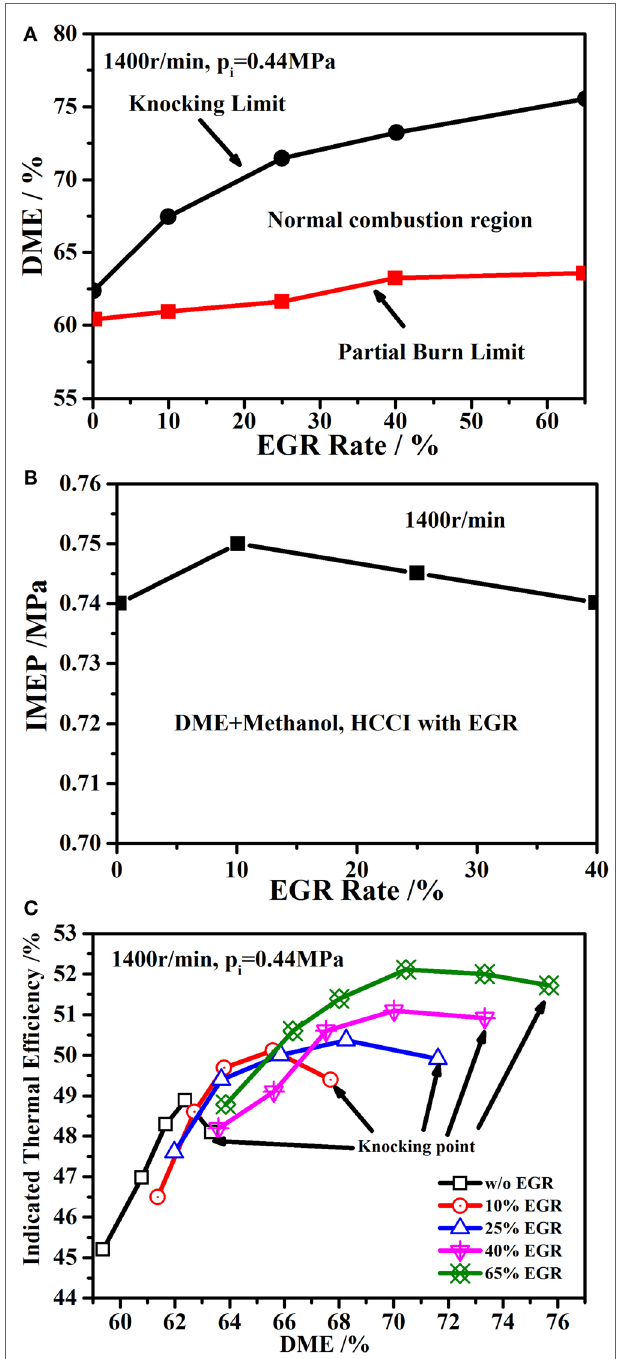
FiGURe 4 | (A) The effects of EGR on operating load range, (B) the effects of EGR on the maximum loads, (C) the effects of EGR on indicated thermal efficiency.